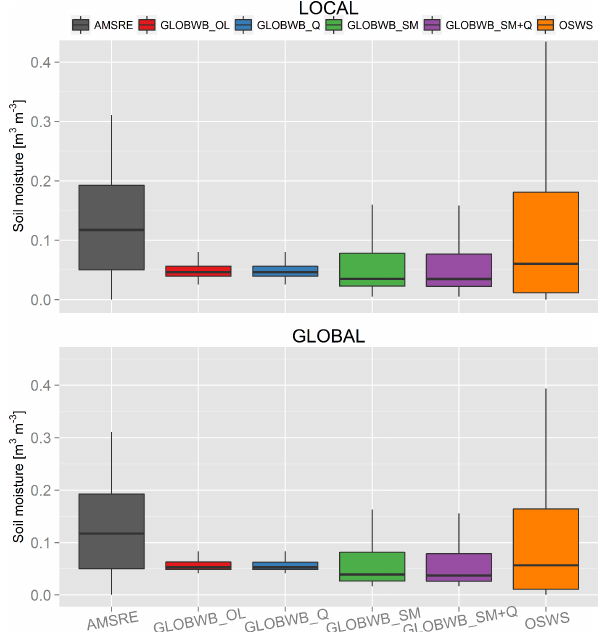
Figure 7. Boxplots of the catchment daily means of soil moisture in the Murrumbidgee River basin. The upper panel shows soil mois- ture when local data are used as model forcing. Soil moisture ob- tained with the global forced models is shown in the lower panel. Boxplots of each panel illustrate the first and third quantile ranges (box), the median (dark line) and the maximum–minimum range (whiskers) of soil moisture